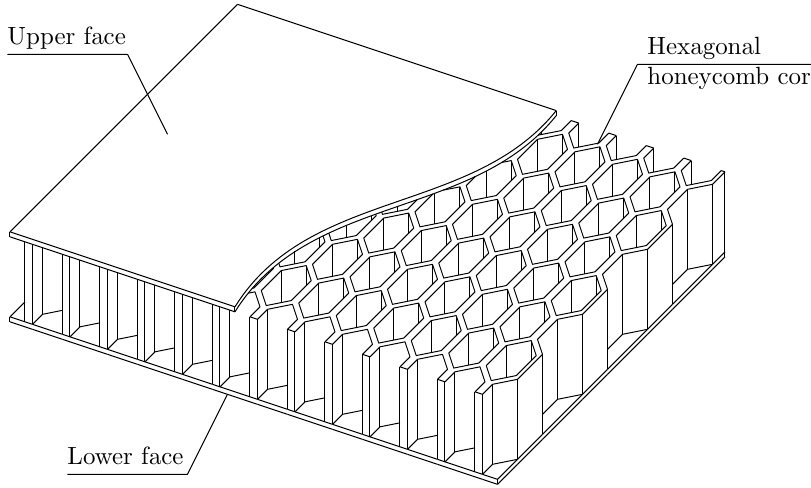
Figure 1. Sandwich plate with hexagonal honeycomb